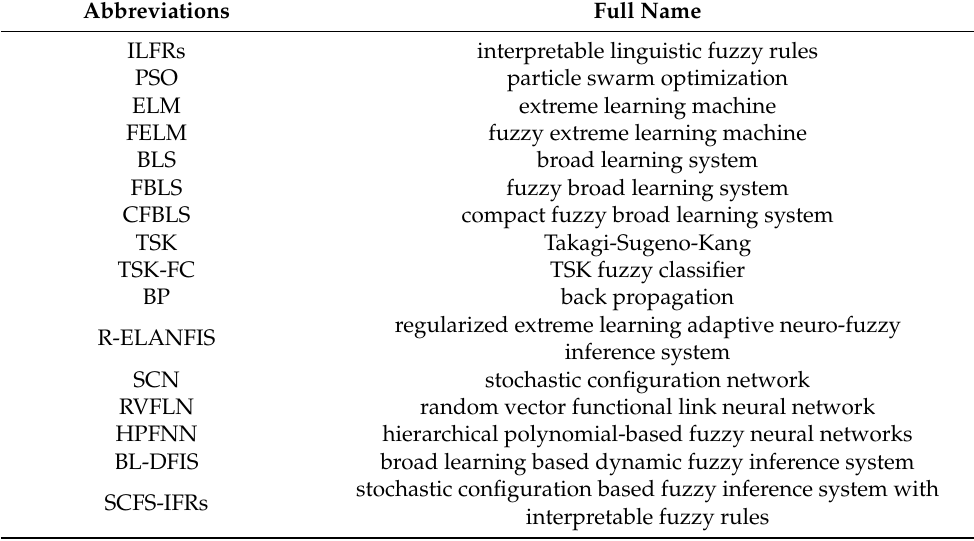
Table 1. Table of abbreviations.